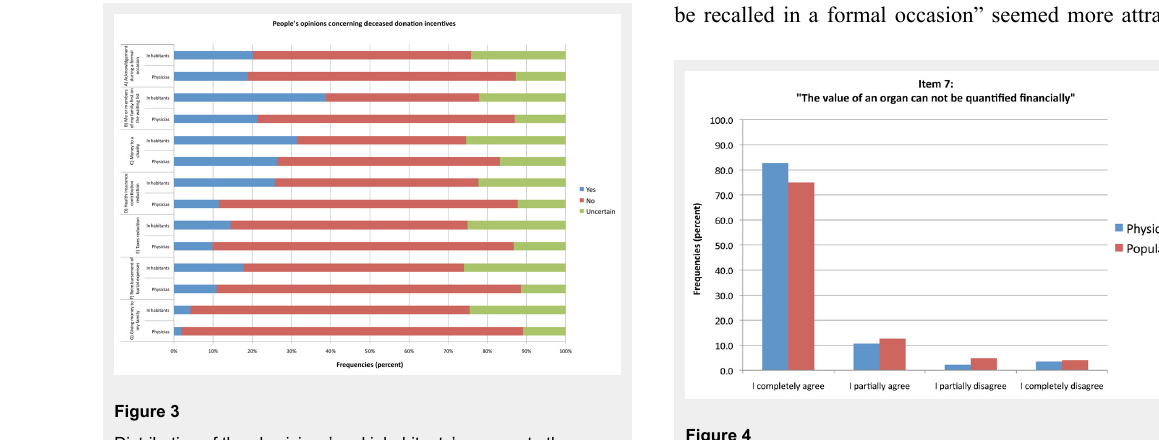
Distribution of the physicians’ and inhabitants’ answers to the different living organ donation incentive propositions.